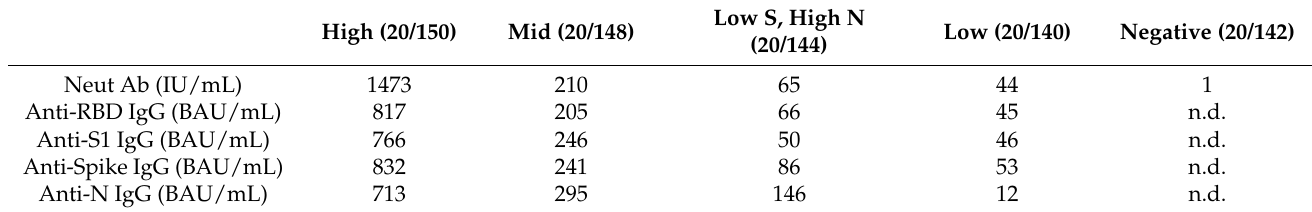
Table 1. Anti-SARS-CoV-2 antibody titres are calculated as the geometric mean of the potencies obtained from the collaborative study participants calibrated against the WHO International Standard for anti-SARS-CoV-2 immunoglobulin (NIBSC 20/136). The five components are shown at the top with corresponding NIBSC code in brackets. Neutralising antibody (Neut Ab), anti-receptor binding domain (anti-RBD), anti-spike 1 subunit (Anti-S1), anti-spike (Anti-S1/S2), anti-nucleocapsid (Anti-N) rows are listed. IU: International Units; BAU: binding antibody units; n.d.: not detected. Low S, High N High (20/150) Mid (20/148) Low (20/144)